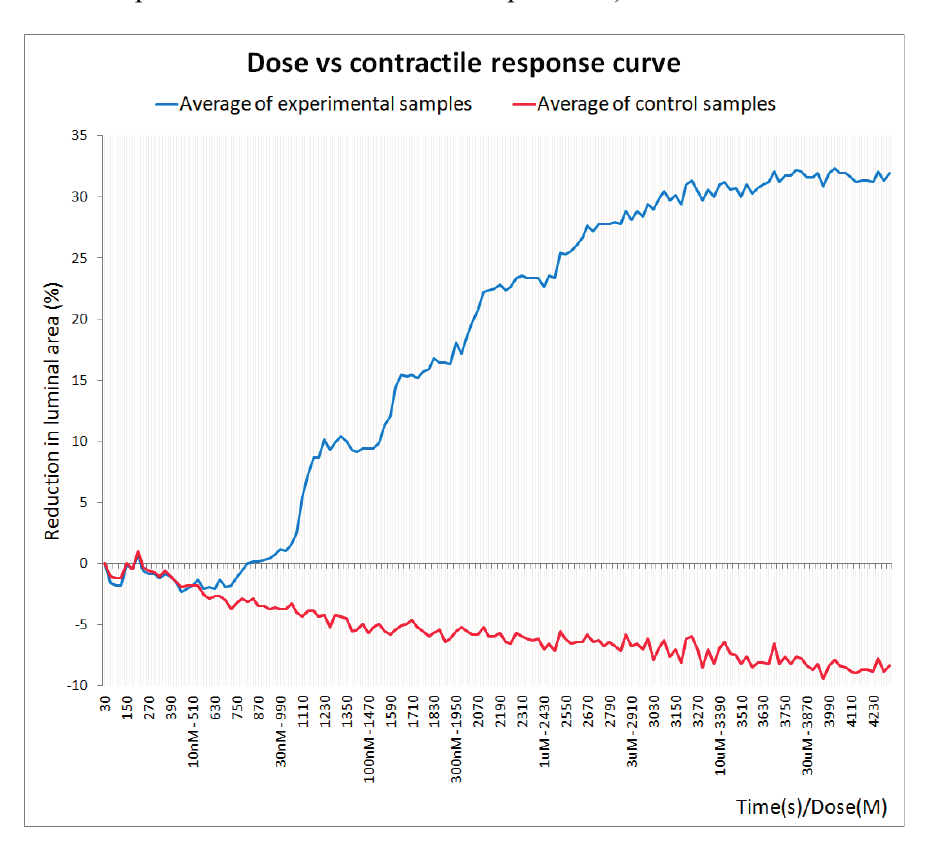
Figure 5. Dose-response curve obtained with the image processing